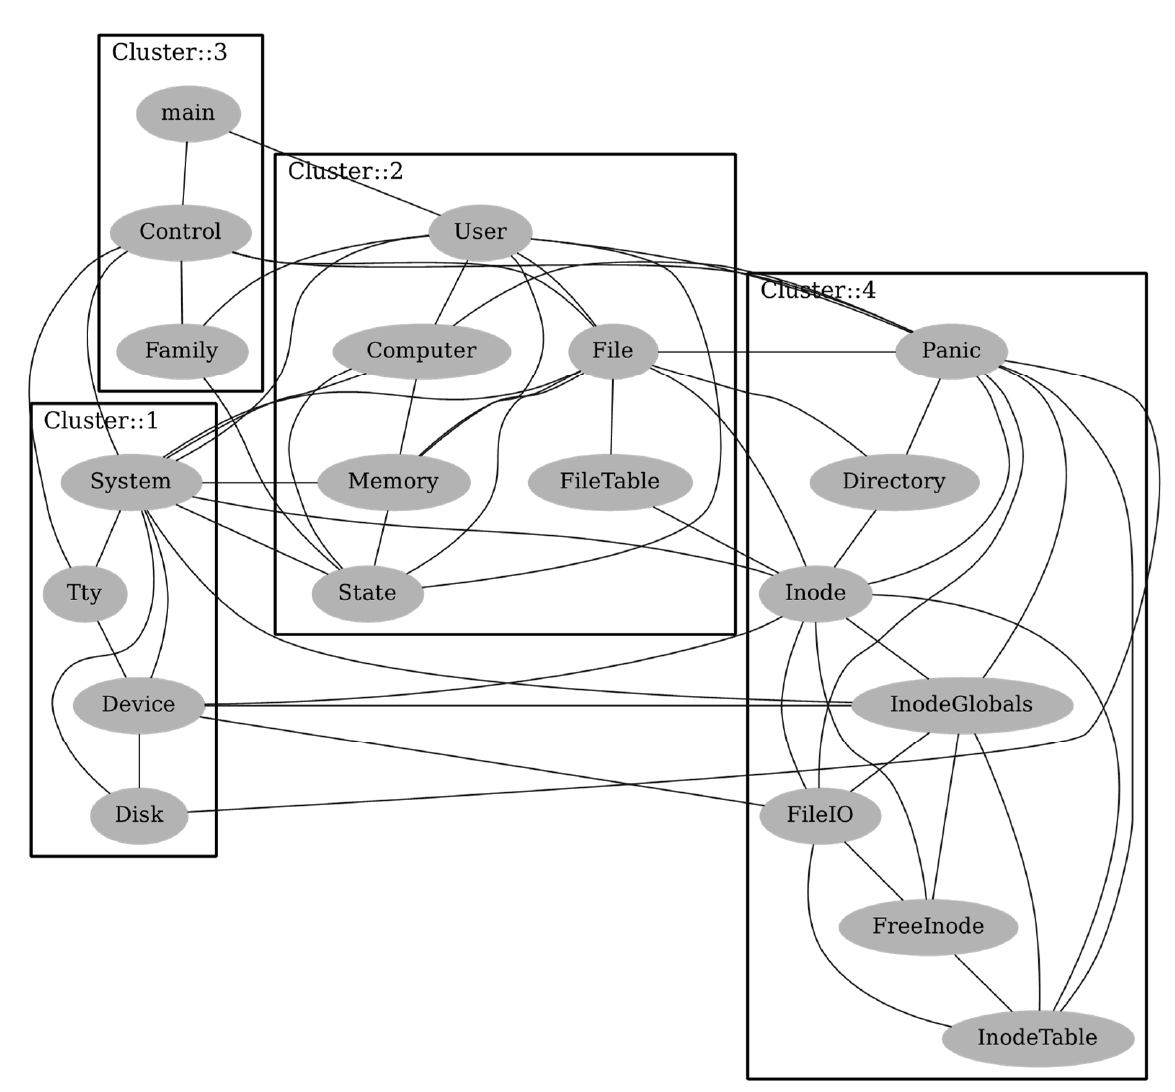
Figure 7. Mutins system after applying the HHMO_CF_GDA approach.